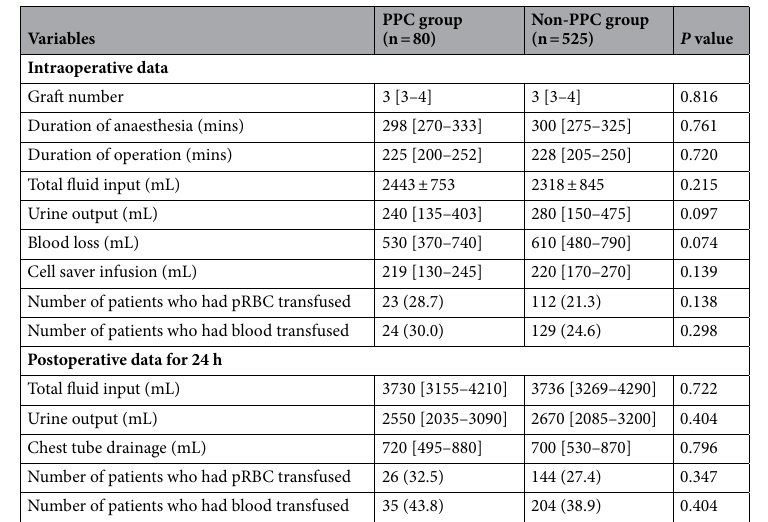
Table 2. Intra- and post-operative data. Values are presented as means ± standard deviations, medians [interquartile ranges], or the number of patients (percentages). PPC, postoperative pulmonary complication; pRBC, packed red blood